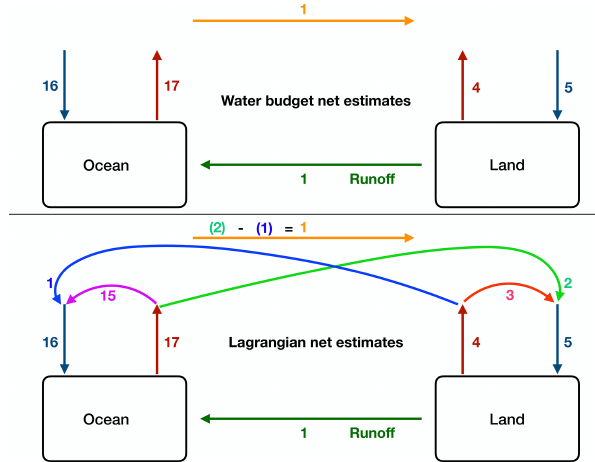
Figure 7. A sketch of the atmospheric water exchange between the global ocean and land. The top panel shows the surface water bud- get understanding of the hydrologic cycle, while the bottom panel elaborates the intricacies of the water movement that can be ob- tained using a Lagrangian framework. The upward and downward arrows represent net evaporation and net precipitation transport, re- spectively. Note, the numbers presented here are the crudely esti- mated transports from Table 1 and have not been used for any quan- tification. Units are in Sverdrups (1Sv ≡ 10 9 kgs − 1 ). It is important to mention that the net evaporation and net precipitation transports presented here are higher (with different magnitudes) than the pre- vious estimates such as Trenberth et al. (2007) and Chahine (1992), and it might be due to the way E − P has been computed in the present study which omits diffusive atmospheric water transport and time